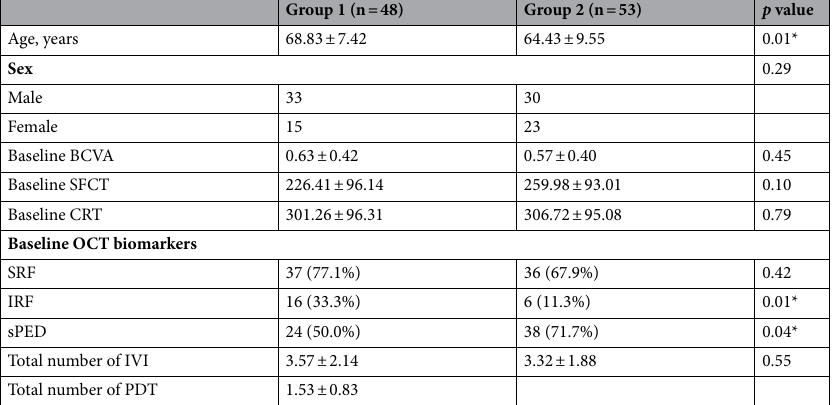
Table 1. Demographics of patients with PCV receiving different treatments. Values are presented as the mean ± standard deviation or number (percentage). Group 1 intravitreal injection of ranibizumab + photodynamic therapy, Group 2 intravitreal injection of aflibercept, BCVA best-corrected visual acuity, CRT central retinal thickness, IRF intraretinal fluid, IVI intravitreal injection, OCT optical coherence tomography, PCV polypoidal choroidal vasculopathy, PDT photodynamic therapy, SFCT subfoveal choroidal thickness, sPED serous pigment epithelial detachment, SRF subretinal fluid. *Indicates chi-squared test; otherwise, t test.